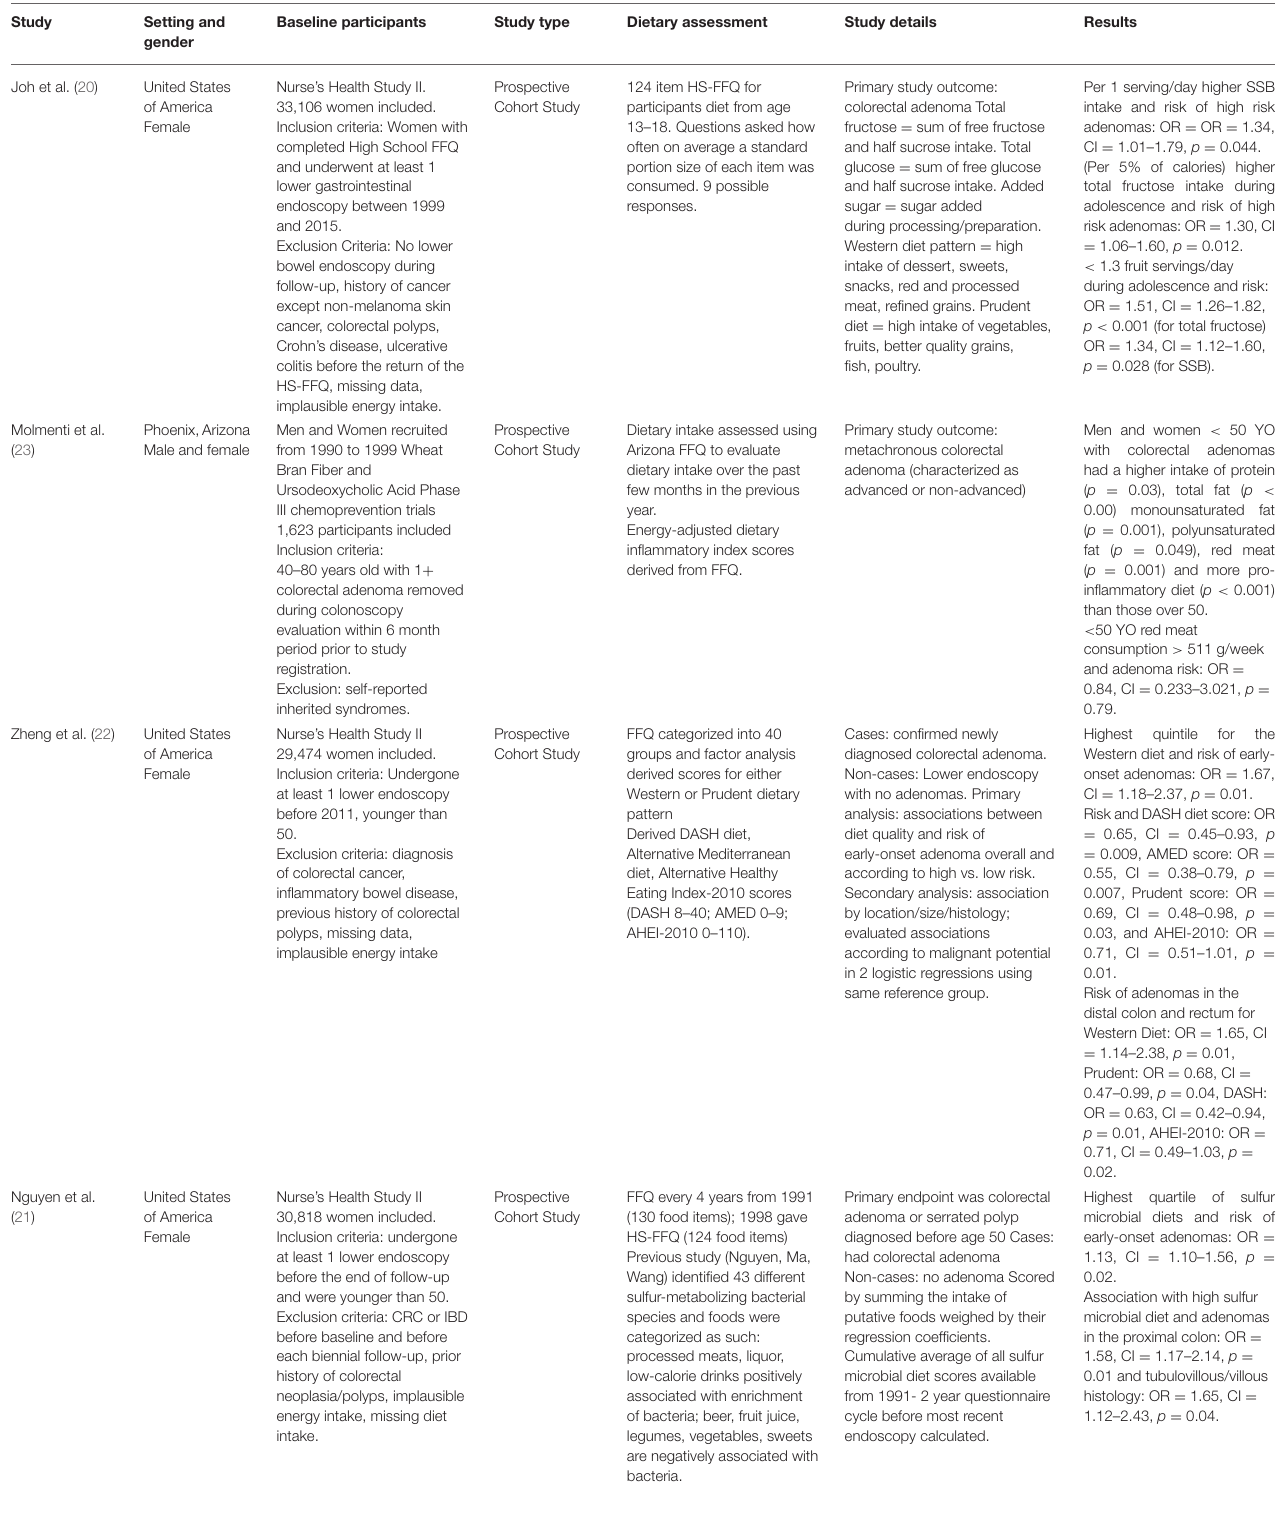
TABLE 2 | Characteristics of included studies (early-onset colorectal